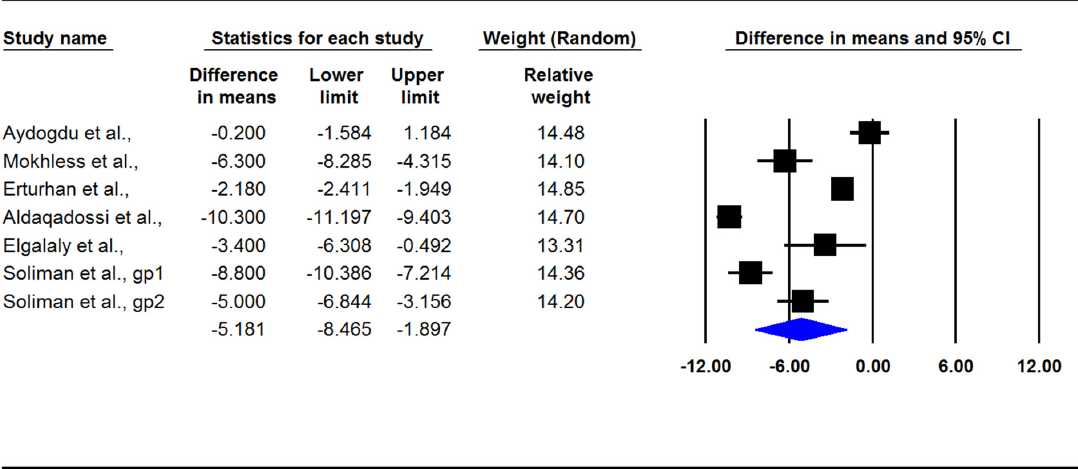
Figure 4. Forest plot for the differences in the means of the stone expulsion time [3,12–16].